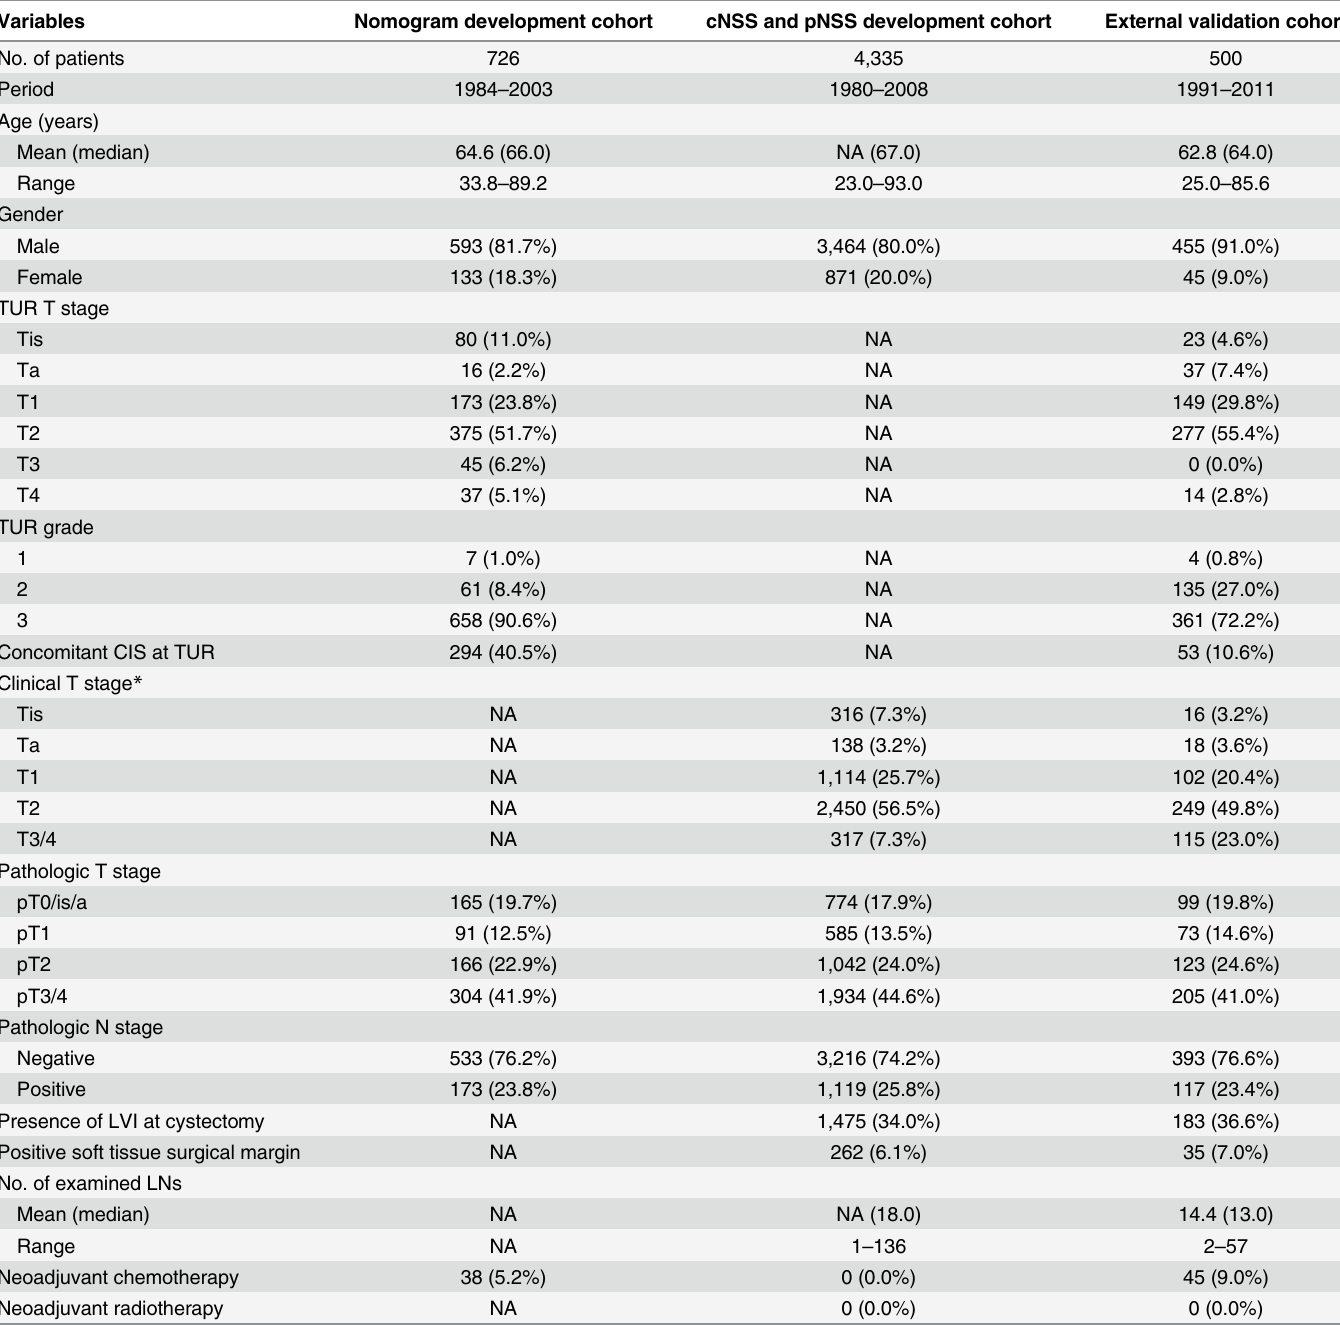
Table 1. Clinical and pathologic characteristics of patients treated with radical cystectomy for urothelial carcinomas of the urinary